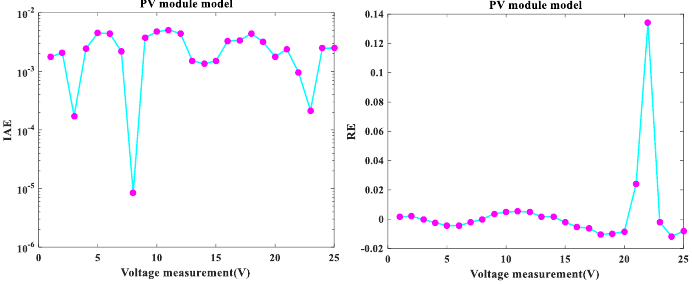
Figure 6. MLCPA for PV module single diode I-V characteristics and P-V characteristics.